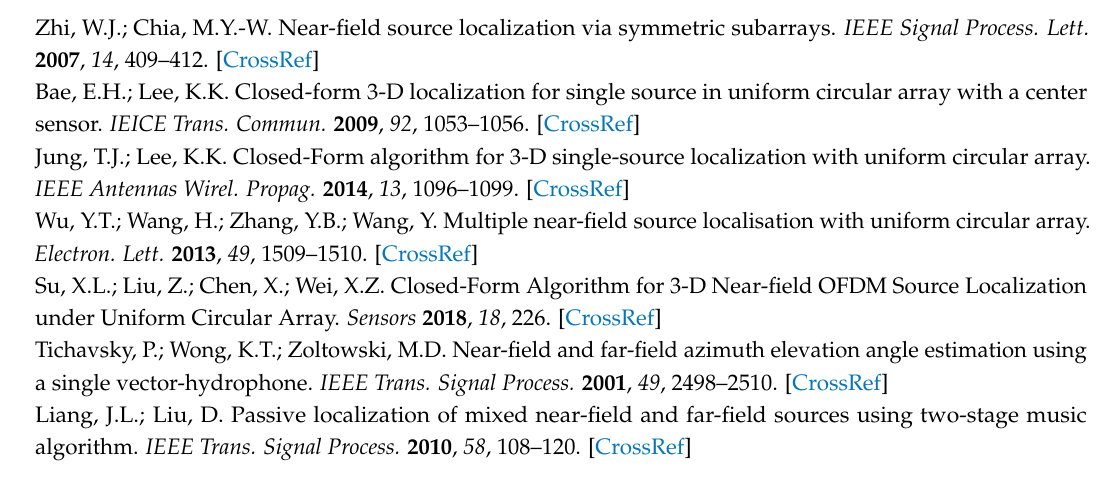
Figure 8. RMSEs versus absolute error of frequency estimation (SNR = 20 dB): ( a ) Azimuth angle; ( b ) Elevation angle; ( c ) Near-field source range.